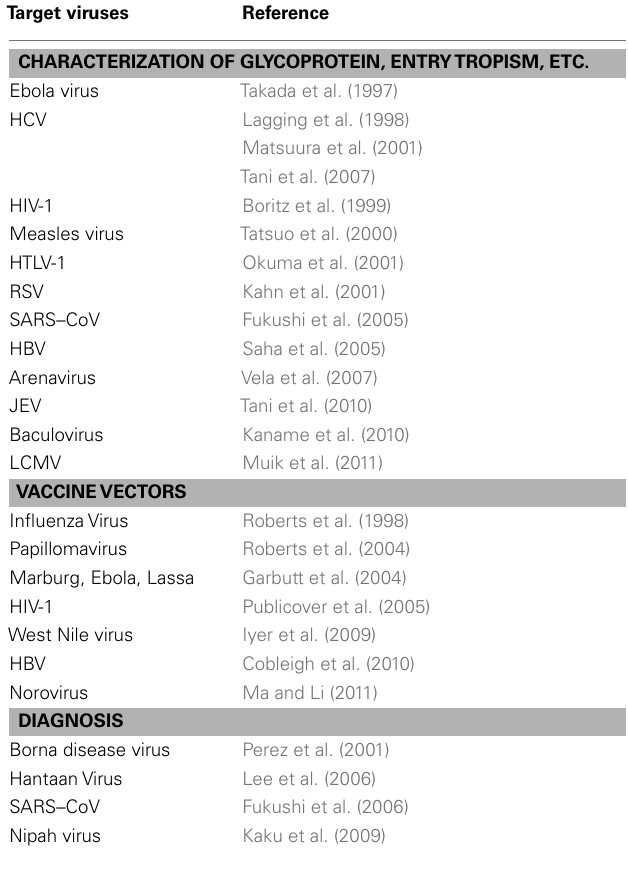
Table 1 |Application studies of pseudotype and